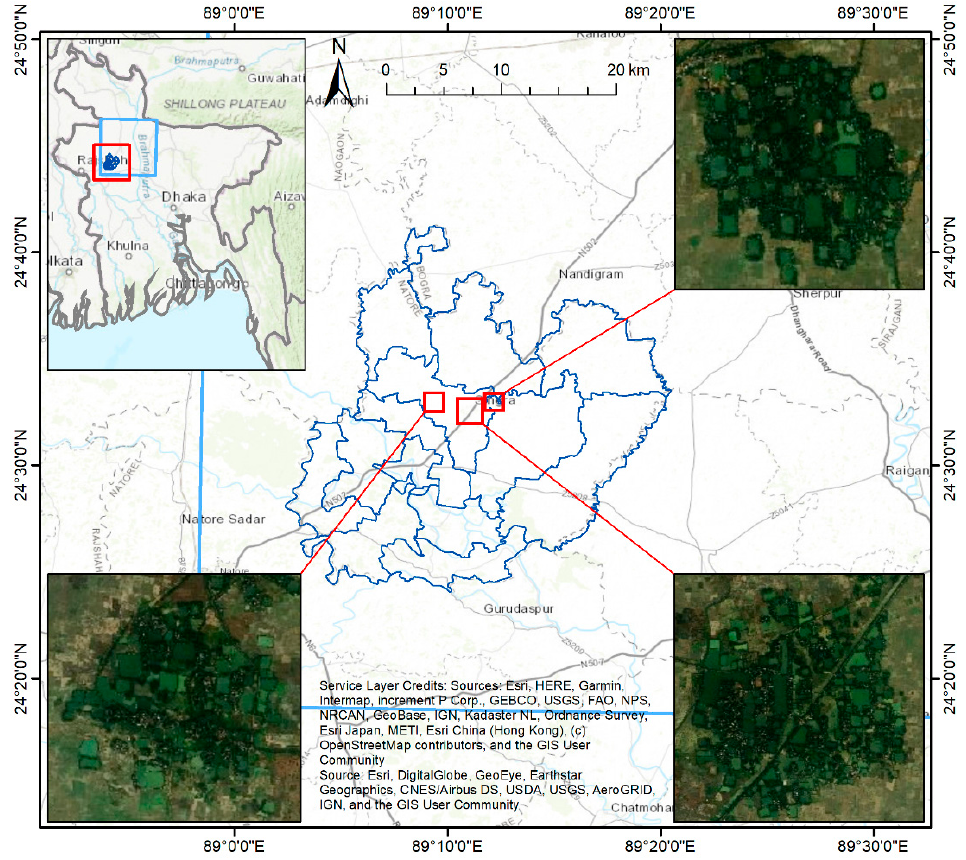
Figure 1. Study area. Upper left: location of the study area in Bangladesh. Upper right, lower left, and lower right: example fishponds within the study area. The blue boundary on the overview map and the main map shows the footprint of the Sentinel-2 image used in this study.